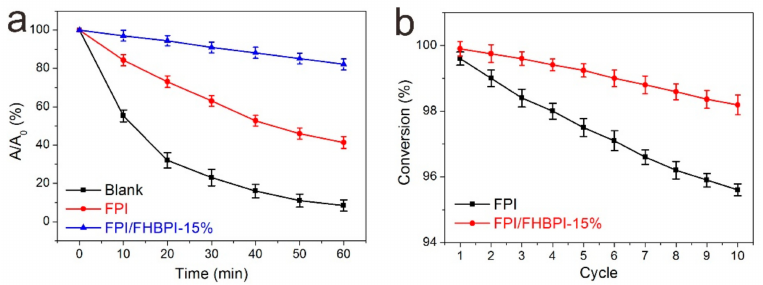
Figure 11. ( a ) Decay curves of the absorption intensity of the MB solution at 665 nm under no protection and protected by FPI and FPI / FHBPI-15% with 0.05 mm thick. ( b ) Recyclability of FPI and FPI / FHBPI-15% with 0.05 mm thick as UV-shielding materials for MB solution.